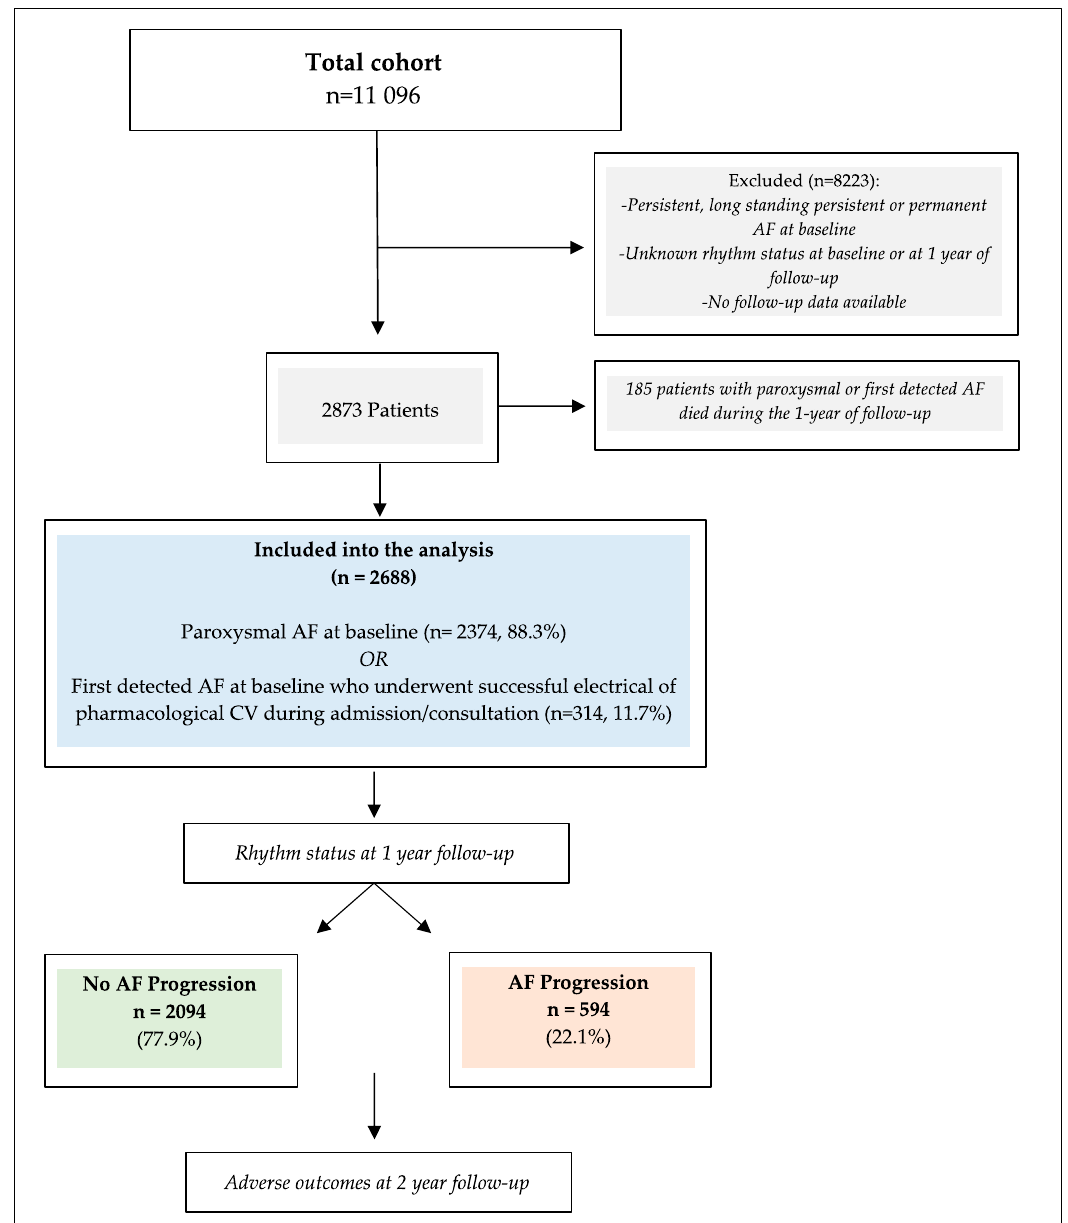
Figure 1. Study flow diagram. AF = atrial fibrillation; CV = cardioversion.